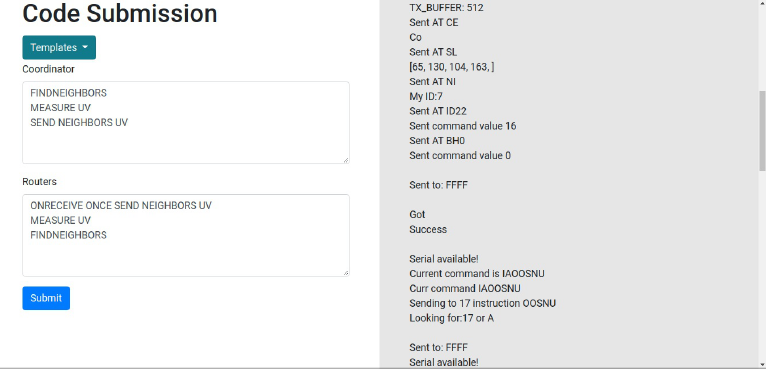
Figure 4. The implemented web framework’s main interface. The submitted code is displayed on the left panel, whereas the Arduino’s output is on the